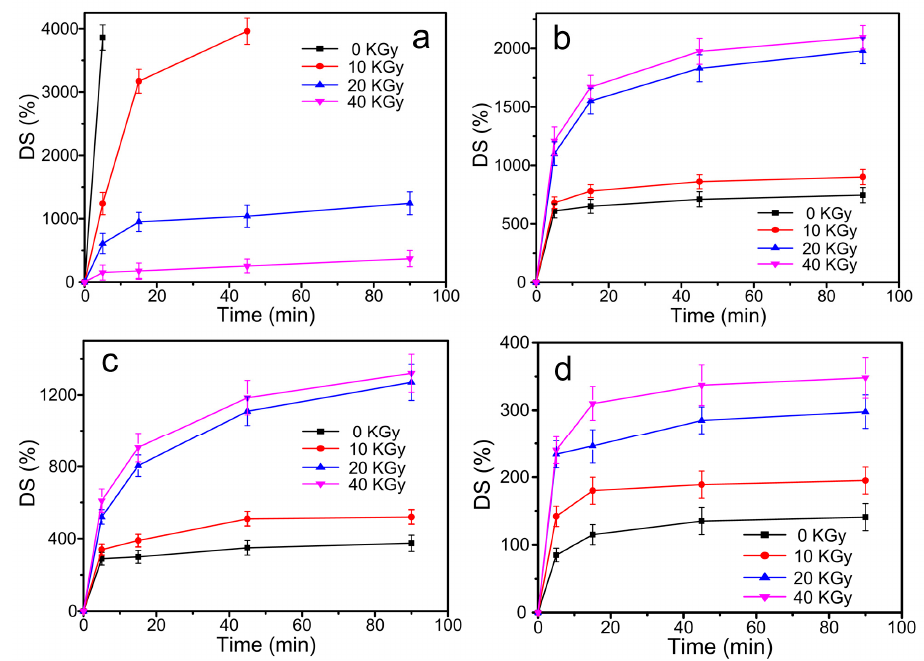
Figure 2. Swelling curves of chitosan (CS)/graphene oxide (GO) composite films with different content of GO: ( a ) 0 wt %; ( b ) 1 wt %; ( c ) 3 wt %; ( d ) 5 wt % under the various irradiation doses.